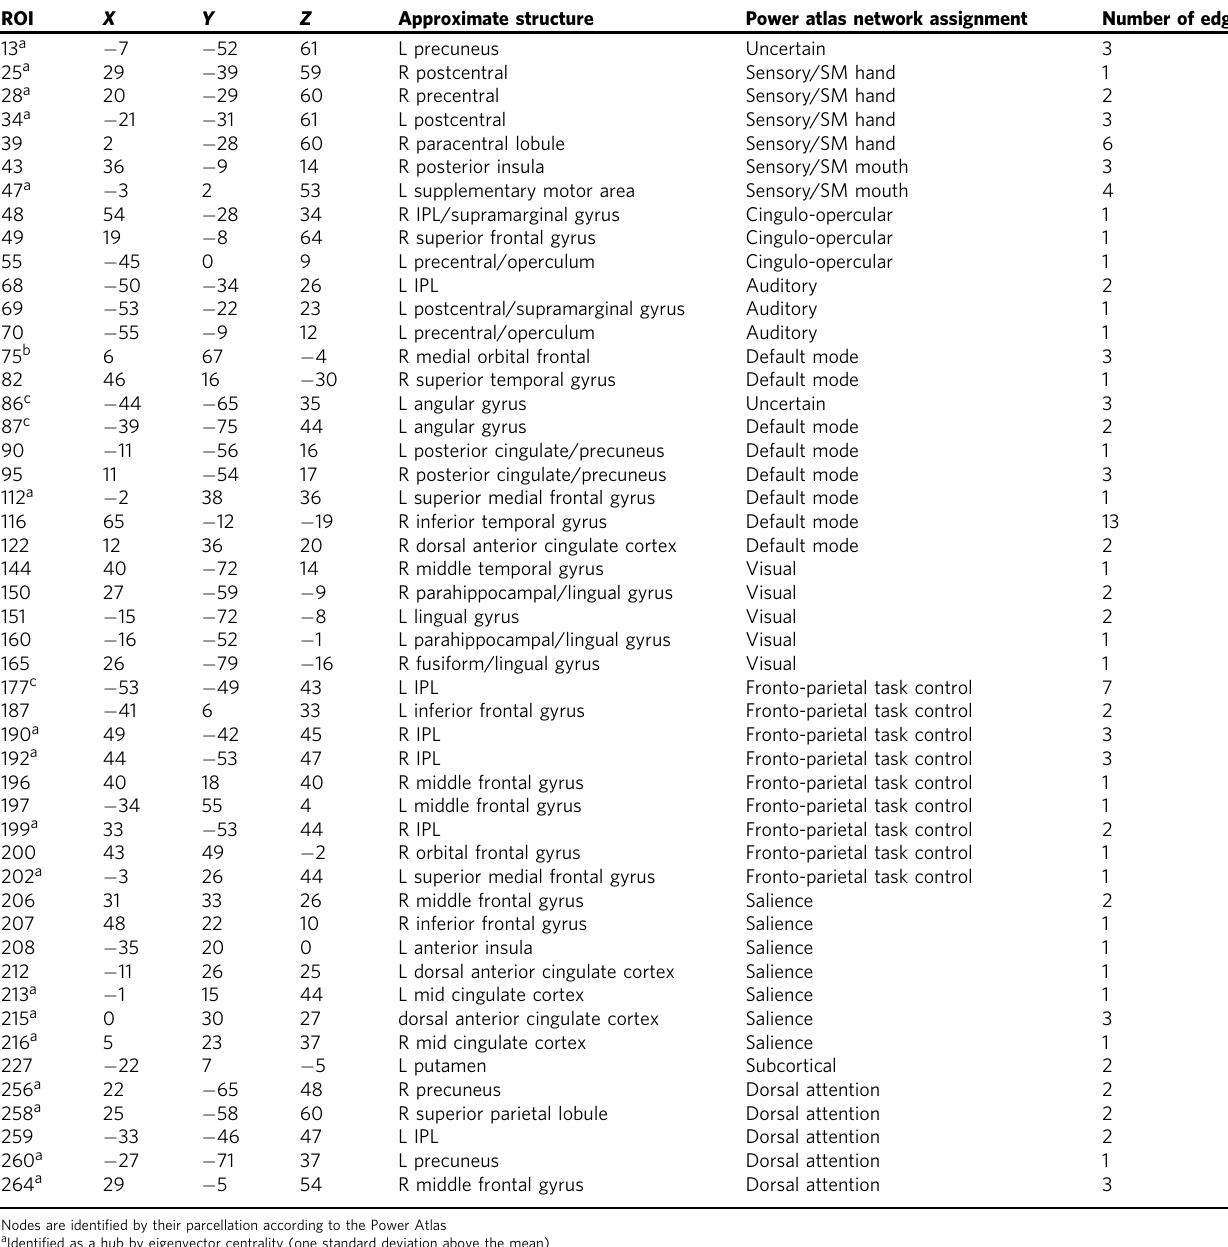
Table 3 Network-Based Statistic nodes for the in fl ammation con fi guration